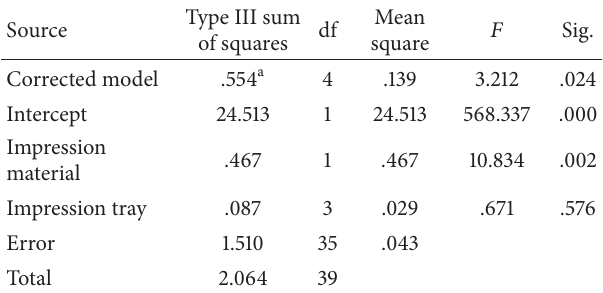
Table 1: Two-way analysis of variance ( 𝜇 m).